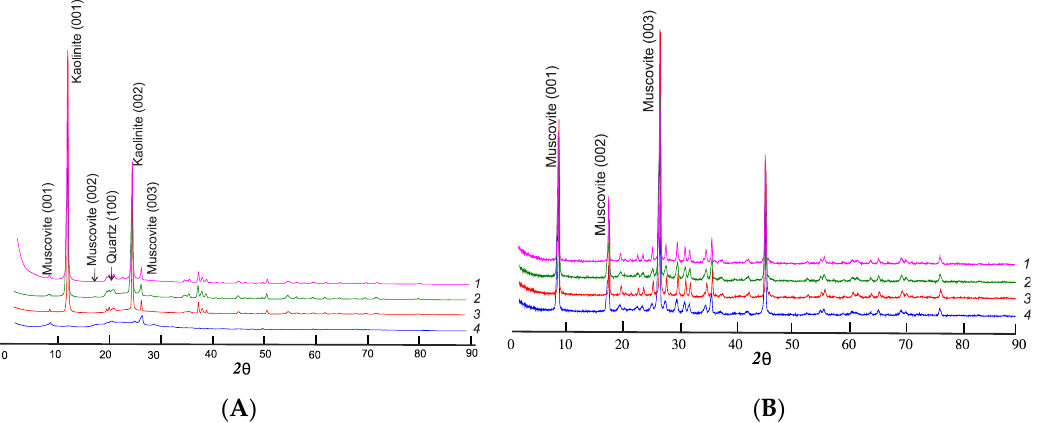
Figure 1. X-ray diffraction (XRD) patterns for kaolinite ( A ) and muscovite ( B ). The air-dried samples 1–4 were saturated with ethylene glycol and calcined at 350 °C and 550 °C, respectively.